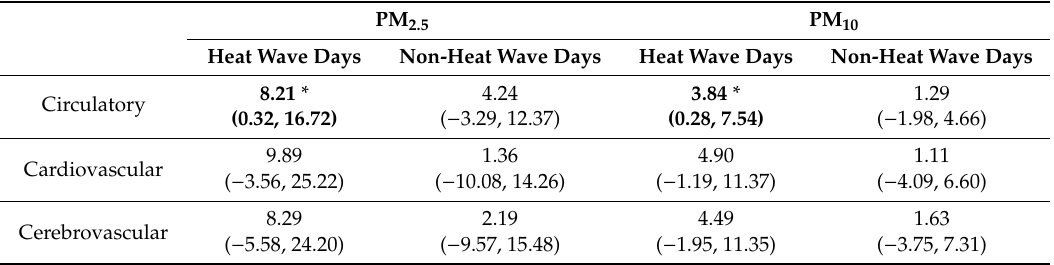
Table 2. Estimates of percent change in daily circulatory mortality associated with a 10 µ g / m 3 increase in particulate matter concentrations during days with heat waves and days without heat waves. The e ff ects are presented as excessive risk with their corresponding 95% confidence intervals.